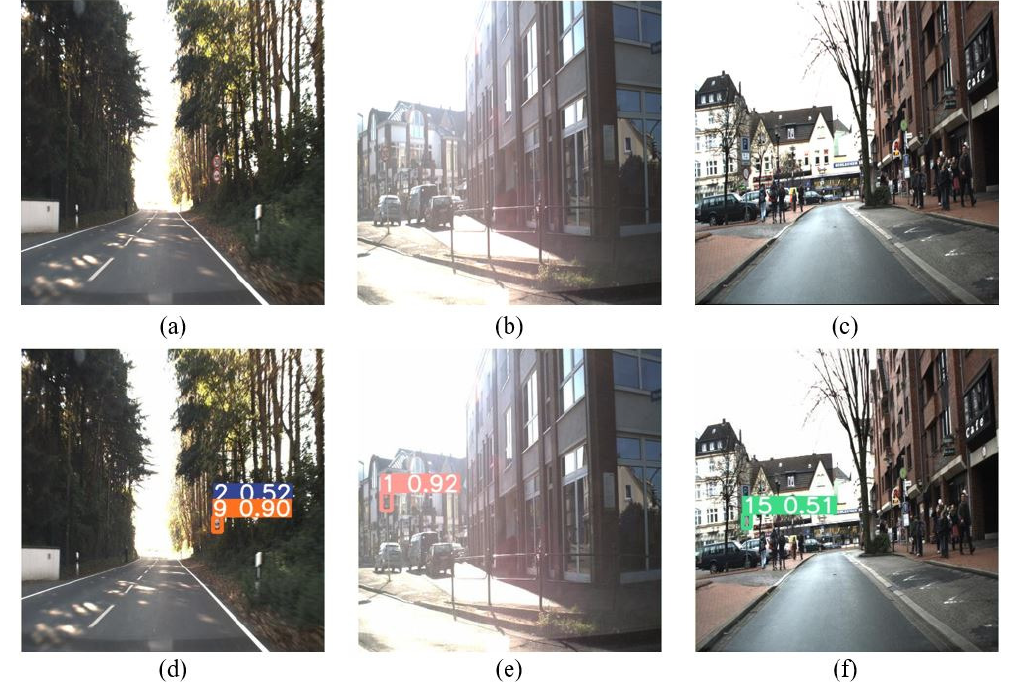
Figure 8. Traffic sign detection results using the FSADD—part 2: ( a ) ground truth—2 and 9, ( b ) ground truth—1, ( c ) ground truth—15, ( d ) detection results of ( a ), ( e ) detection results of ( b ), and ( f ) detection results of ( c